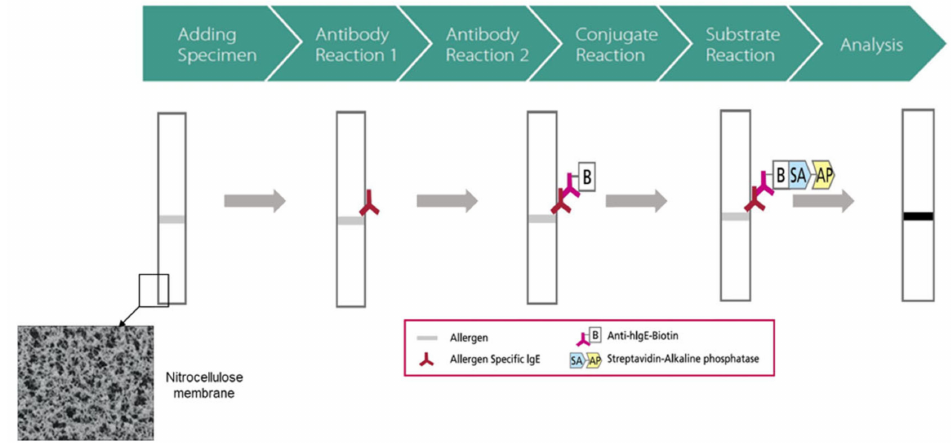
Figure 1. Schematic explanation of the measurement principle of the multiple allergen simultaneous test-immunoblot assay (AdvanSure AlloStation Smart